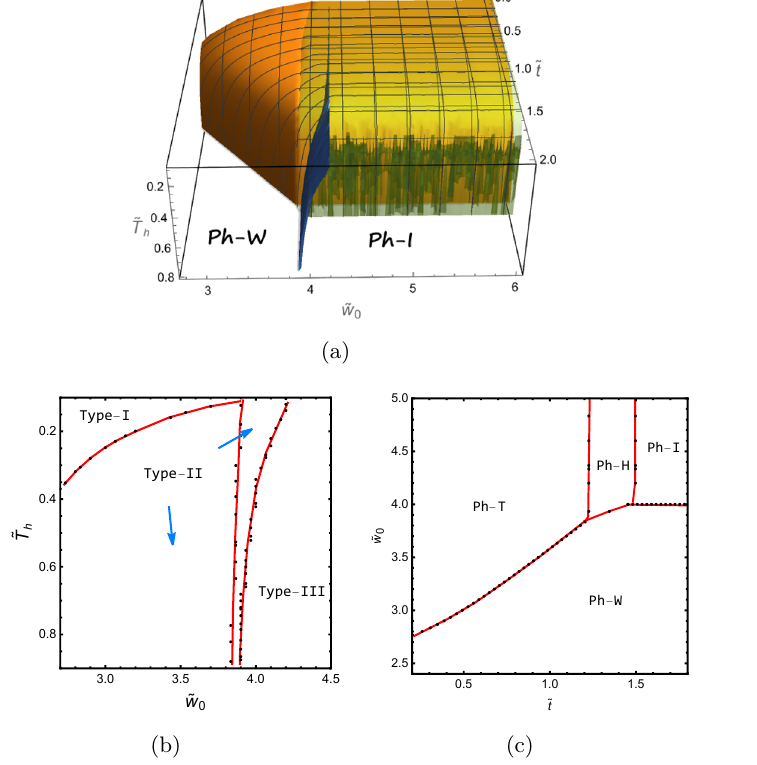
˜ Figure 9 . (a): phase diagram in { ˜ w 0 , ˜ t, T h } . The region inside the orange surface is in Ph- T . The region enclosed by the orange and the green surface is in Ph- H . While the region outside the green surface is divided by the blue surface into Ph- W and Ph- I . (b): the different types of evolution. Here the left-most red curve ˜ w ( ˜ T ) and the right-most red curve ˜ w ( ˜ T ) are two critical distances. c 1 h c 2 h ˜ t } (c): for ˜ T = 0 . 36 , the projected phase diagram in { ˜ w h 0 ,